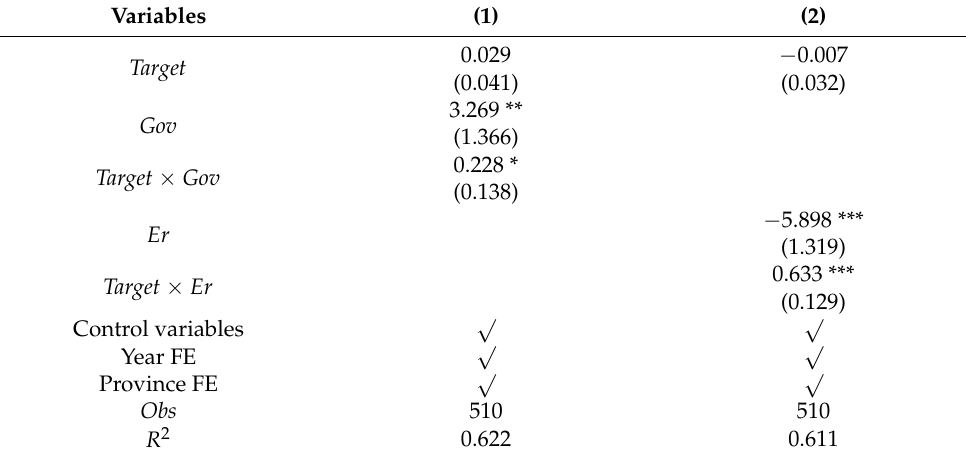
Table 6. Moderating effect